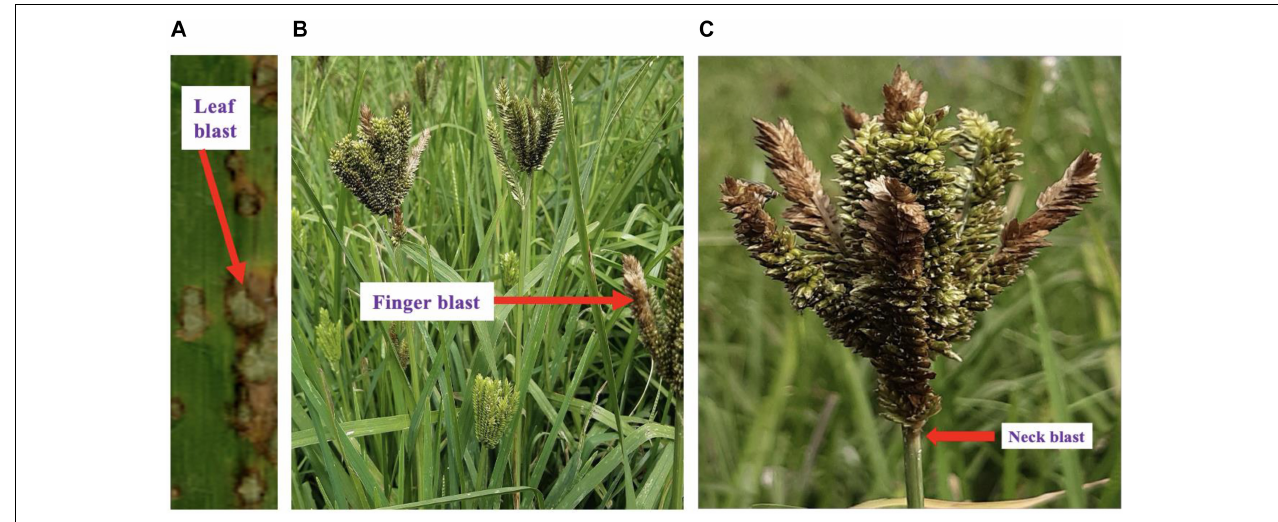
FIGURE 1 | Blast disease symptoms on finger millet (A) blast infection of the finger millet l (B) . infection on leaves (C) . panicle and neck bast